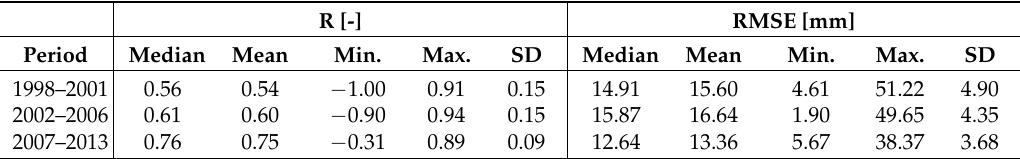
Table 5. Correlation coefficients (R) and root mean square error (RMSE) for the accumulated rainfall estimates derived from 5-day SM2RAIN-CCI against the GBGR dataset during the three calibration periods 1998–2001, 2002–2006, and 2007–2013. The median, mean, minimum, maximum, and standard deviation values for each performance metric are